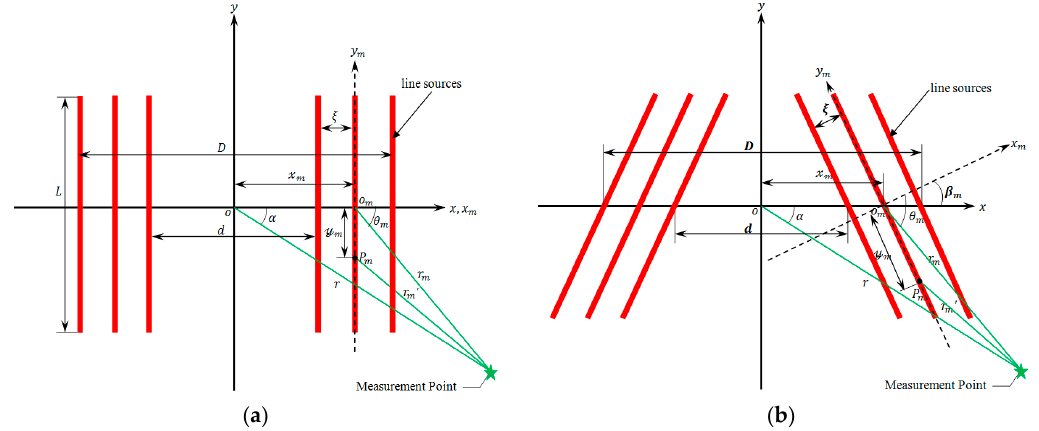
Figure 1. Distributed line sources models: ( a ) Conventional PPM EMATs; ( b ) Proposed PPM